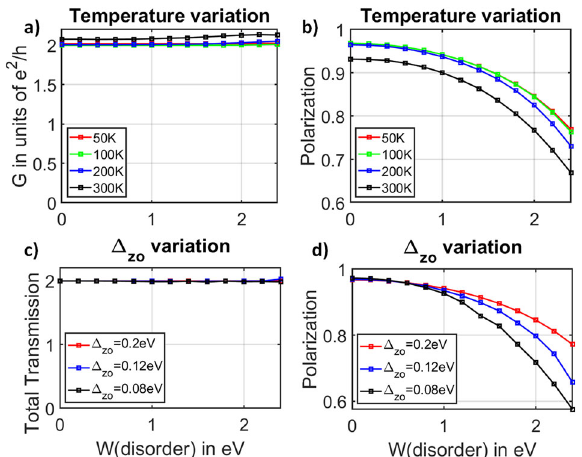
Fig. 8 Effect of temperature variation and Δ zo variation on valley fi lter performance. a , b Effect of temperature variation on zero-bias conductance G and valley polarization Pv ( c , d ) Effect of Δ zo variation on on zero-bias conductance G and valley polarization Pv . The different cases of Δ zo chosen are 0.2, 0.12, and 0.08 eV, correspond- ing to E zo = 5, 3, and 2 V nm − 1